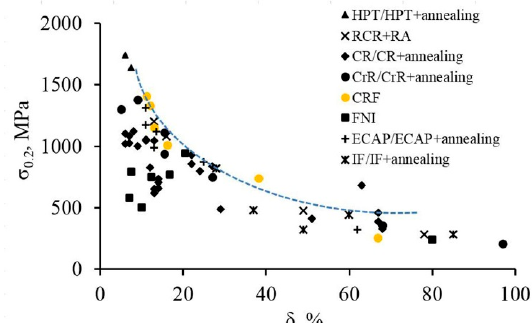
Figure 10. Yield strength—elongation to fracture relation of the 321 MASS after different strengthening treatment methods. Note: high pressure torsion (HPT) [45], repetitive cold rolling and reversion annealing (RCR + RA) [46], cold rolling (CR) [1,47], cryogenic rolling (CrR) [48,49], cold radial forging (CRF), fast neutron irradiation (FNI) [50], equal channel angular pressing (ECAP) [15,16], isothermal forging (IF) [49].